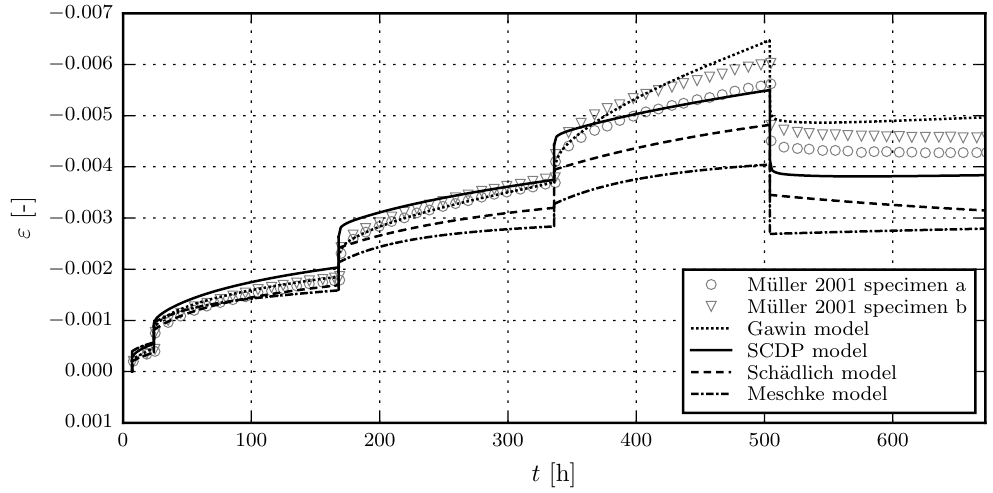
Figure 7. Evolution of the total strain in creep tests on unsealed specimens: Validation of the shotcrete models by means of the test data from creep test series 4/1 by Müller [17].